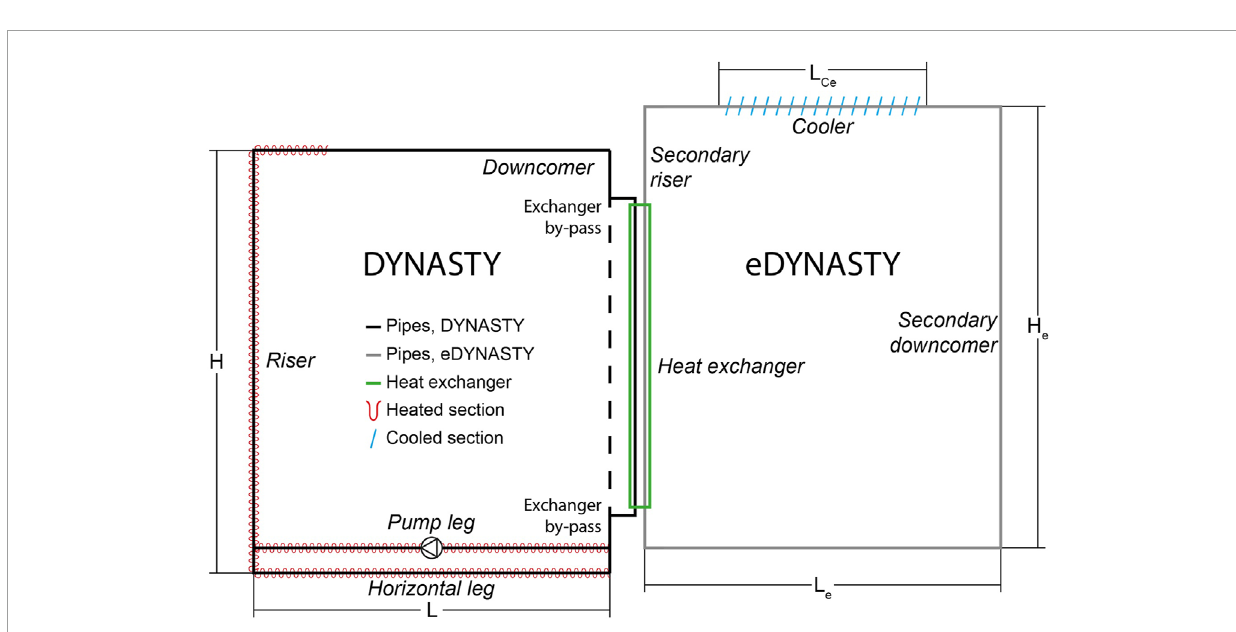
FIGURE 4 Schematic view of the coupled DYNASTY–eDYNASTY loop when using the eDYNASTY